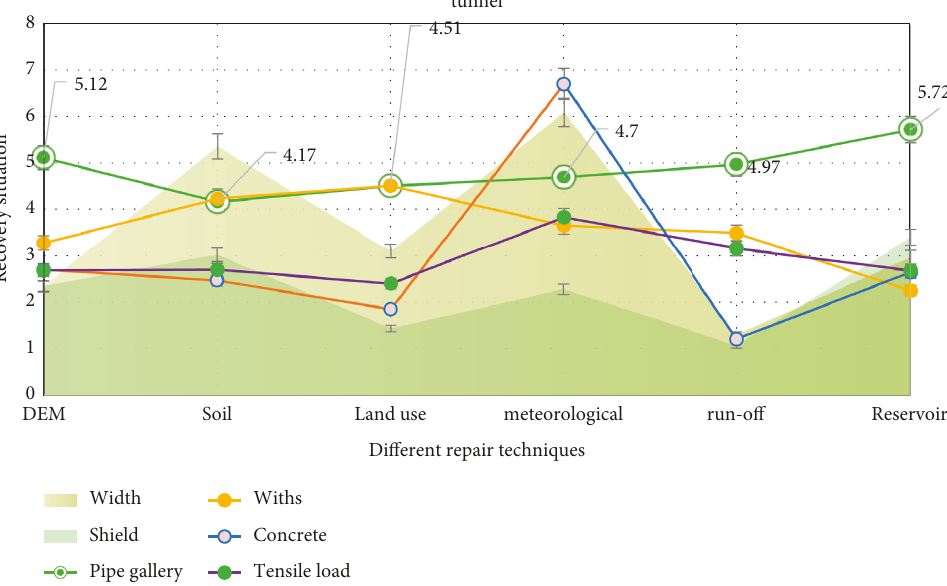
Figure 4: Failure characteristics of the staggered joint structure of high water pressure